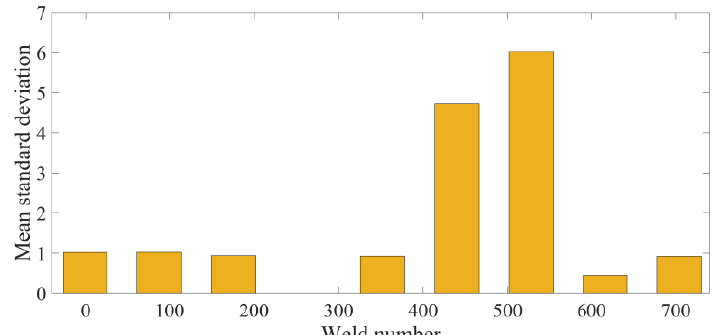
Figure 12. The average standard deviation of peak load, maximum displacement, and failure energy of the welded joints during the failure process of the electrodes.